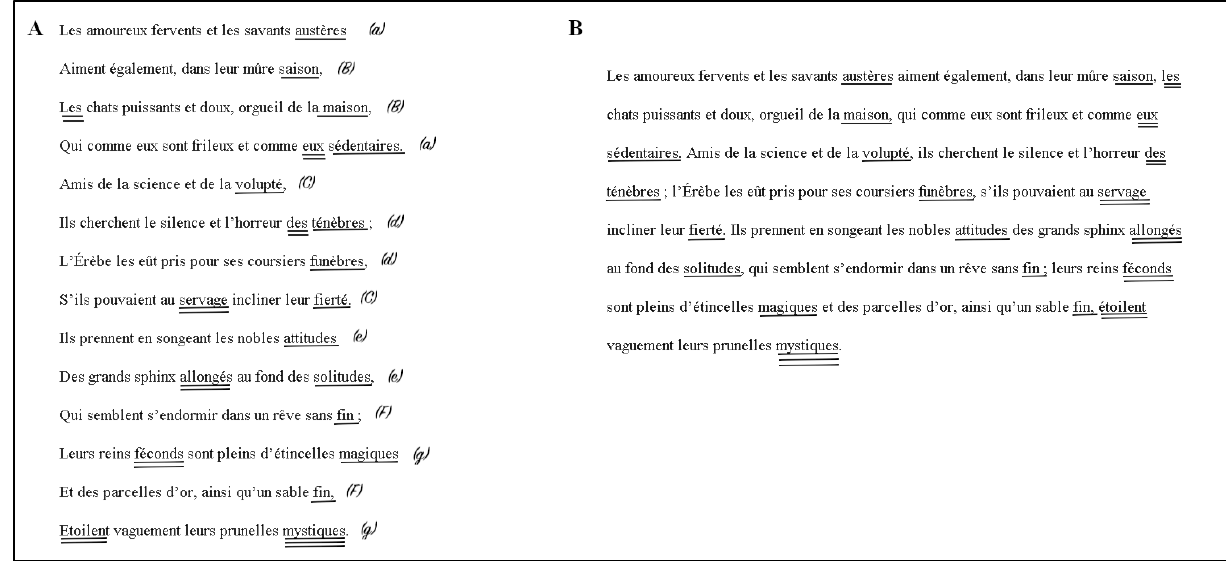
Figure 1. Verse (A) vs. prose presentation (B) of the sonnet Les